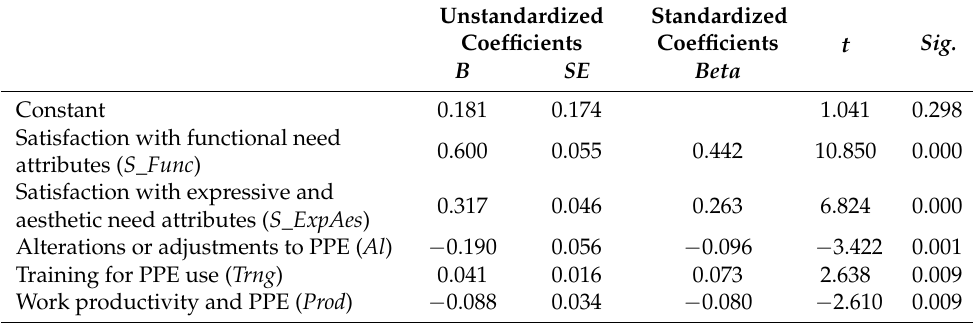
Table 4. The best-fit regression